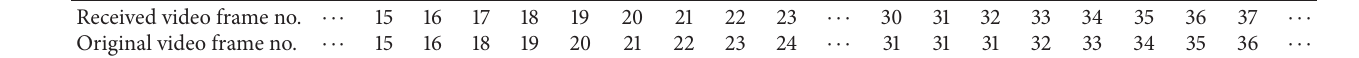
Table 4: VFD algorithm frame calibration example.